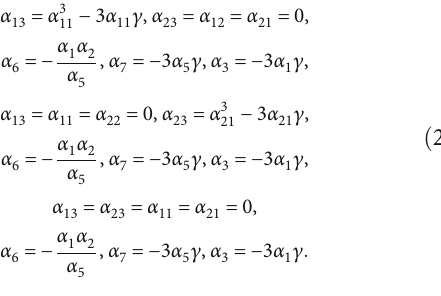
= α = α = 3 , γ = α 2 2 21